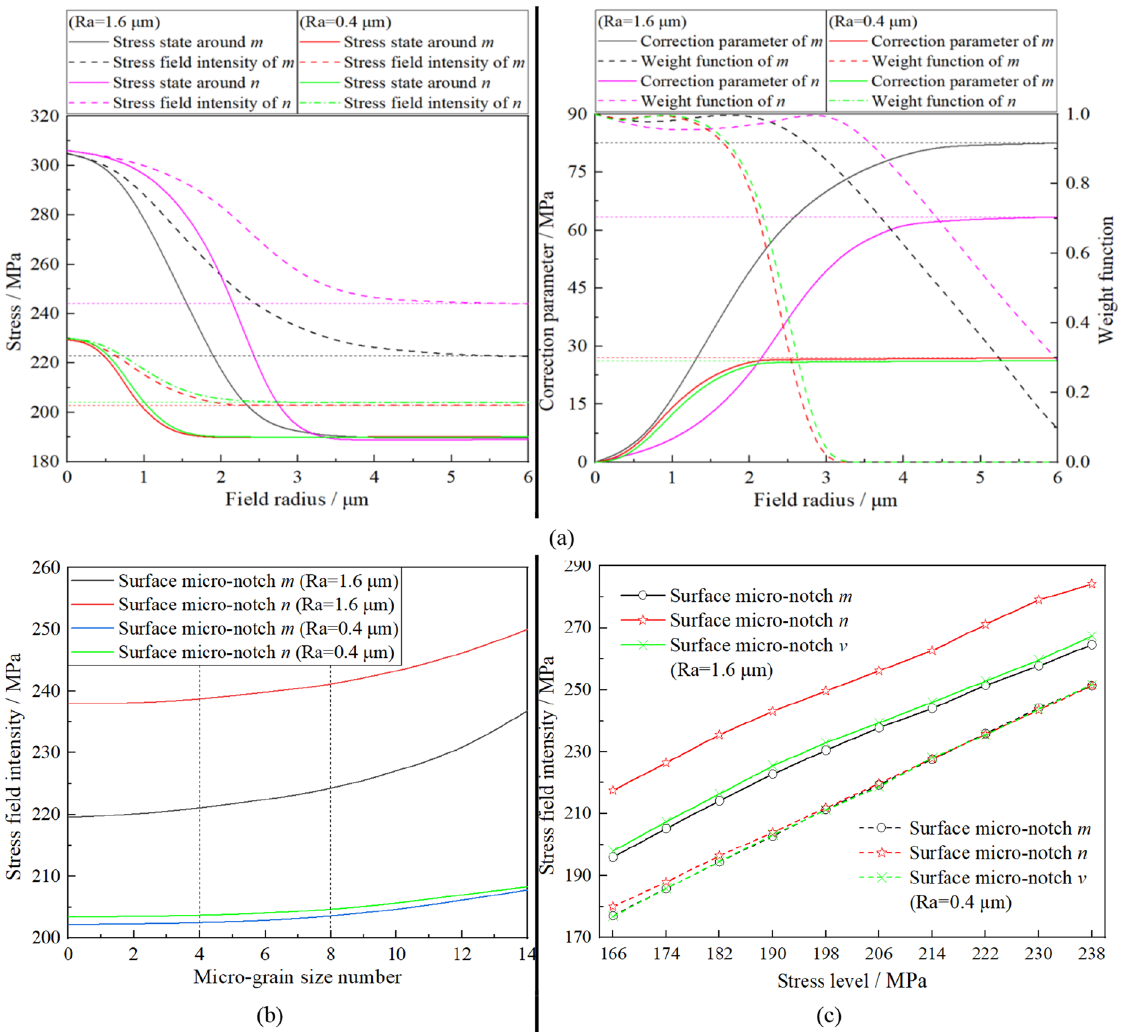
Figure 11. Calculation of fatigue damage parameter by the revised approach with different surface roughness: ( a ) Stress field analyses around different micro-notches; ( b ) Grain size effect on computational result; ( c ) Stress field intensities of different micro-notches under the different stress